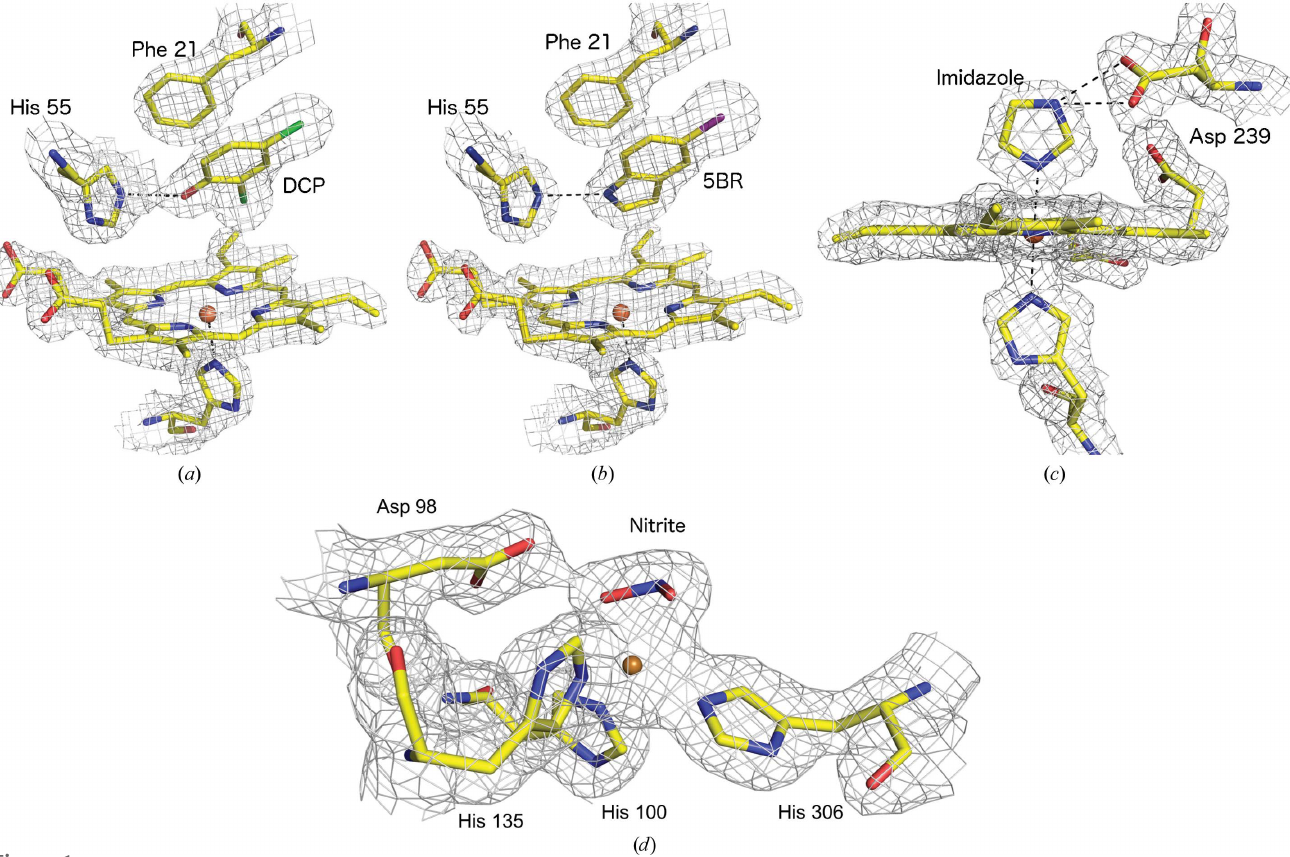
Figure 1 2 F o (cid:3) F c electron-density maps, contoured at 1 (cid:5) , showing the complexes of DHP with ( a ) DCP with the Cl atoms shown in green and ( b ) 5BR with the Br atom shown in purple, ( c ) the complex of DtpAa with imidazole and ( d ) the complex of Ac NiR with nitrite. In each case, the active site of the monomer with the highest ligand occupancy is shown. The maps in ( a )–( d ) were generated using the all-image data